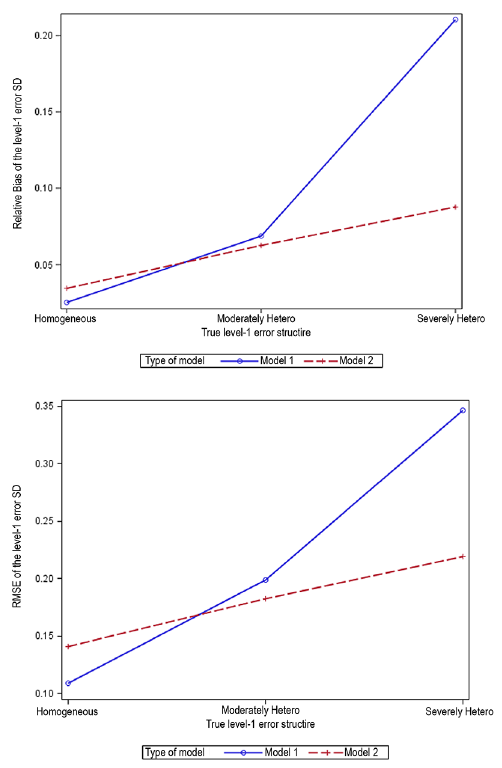
Line Graph Depicting Average Relative Bias and Rmse for the Level-1 Error Standard Deviation as a Function of the Two-Way Interaction Effect Between the Type of Model and the True Level-1 Error